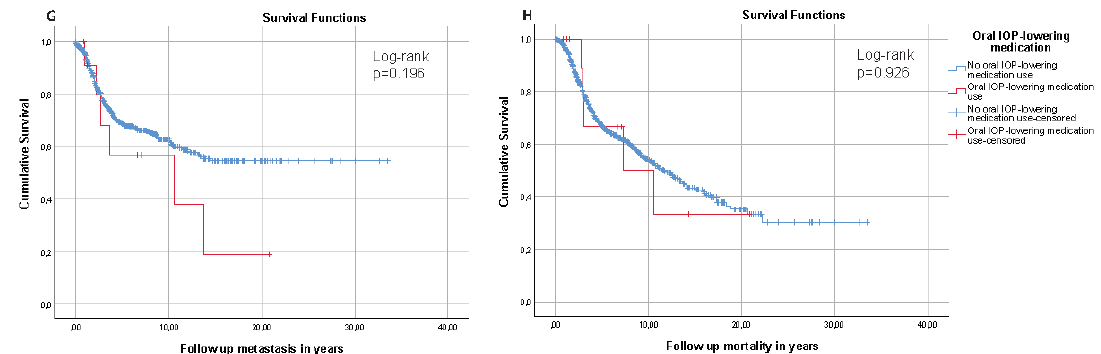
Figure 1. Kaplan–Meier cumulative incidence curves of metastasis ( left ) and mortality ( right ) in uveal melanoma patients with and without prostaglandin/pilocarpine use ( A , B ), with and without beta-blocker use ( C , D ), with and without carbonic anhydrase inhibitor use ( E , F ), and with and without oral intraocular pressure-lowering medication use ( G , H ).